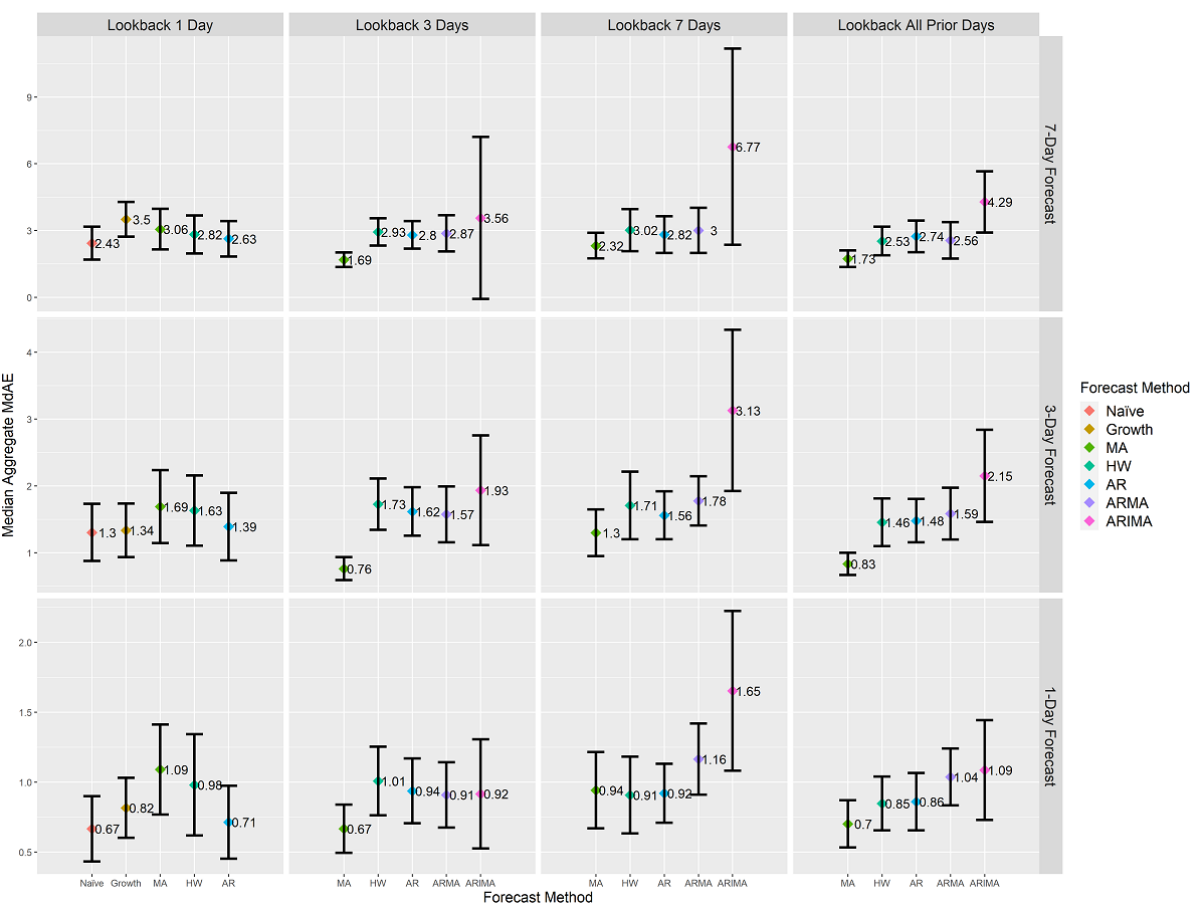
Figure 2. County-level forecasts’ aggregated median MdAE values and 95% CI. CI ranges are calculated using box plot notch ranges around the median. Statistically significant differences at a P value of .01 are identified by nonoverlapping CI ranges of forecasting methods at each combination of forecast length and look-back length. Units are in terms of COVID-19 cumulative case counts. Y-axis scales differ on each row based on the scale of the contained data. Due to differing assumptions, five of the seven forecasting methods are present for each look-back length as indicated on the x-axis. AR: autoregressive; ARIMA: autoregressive integrated moving average; ARMA: autoregressive moving average; HW: Holt-Winters; MA: moving average; MdAE: median absolute